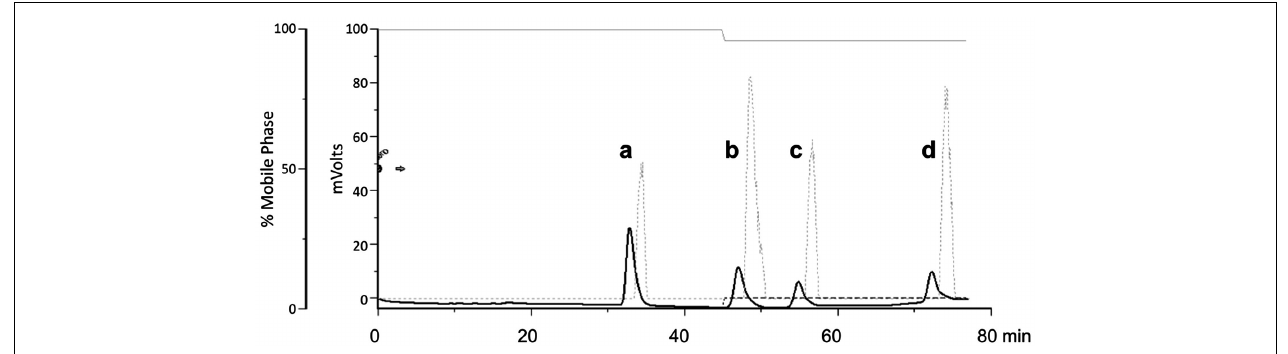
final peaks more rapidly.The solid black line indicates radioinert steroids measured with a UV detector, and the dotted gray line indicates 3 H-labeled steroids measured with a radioflow detector (as described in Mensah-Nyagan et al., 2008; Pradhan et al., 2008, 2010a). Detection of radiolabeled steroids occurs 1.6min later than radioinert steroids because of the extra length of tubing between the UV and radioflow detectors. A fraction collector was then used to collect glucocorticoids for quantification via enzyme immunoassay (EIA) or radioimmunoassay (Taves et al., unpublished